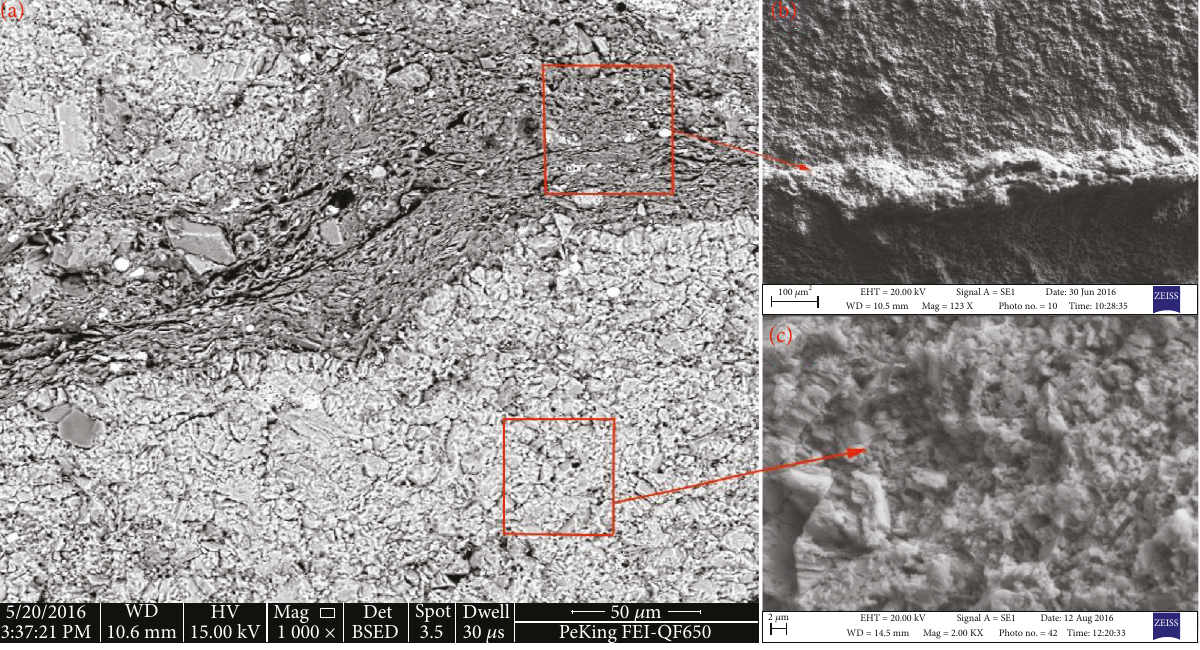
. (a) Preexperiment SEM photomicrographs of S 2